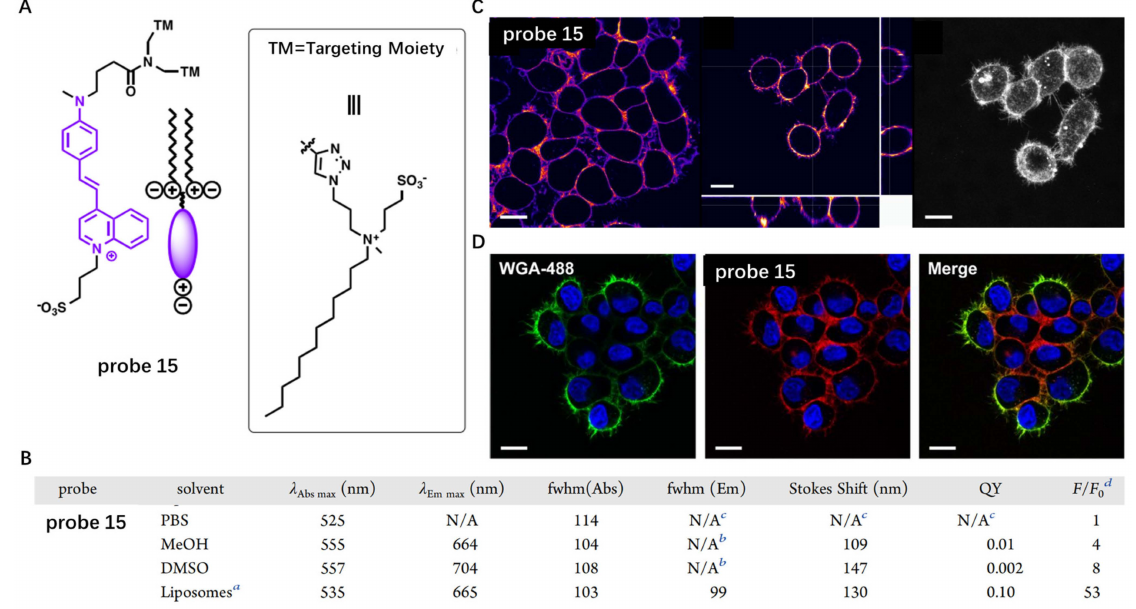
Figure 15. ( A ) Chemical structure of probe 15 . ( B ) The activation of probe 15 in the presence of liposomes. ( C , D ) Confocal imaging of live cells stained with probe 15 and commercial probe WGA- 488. Scale bar: 15 µ m. a Liposomes (size 100 nm) are composed of DOPC (200 µ M final concentration in phosphate buffer 20 mM, pH 7.4). b The low fluorescence intensity did not allow us to determine the fwhm from the spectrum. c No proper fluorescence spectrum was obtained. d Fluorescence enhancement: F = Flu-orescence intensity at λ Em max in the presence of liposomes, F 0 = fluorescence intensity at the same wavelength in PBS. Copyright 2020 American Chemical Society